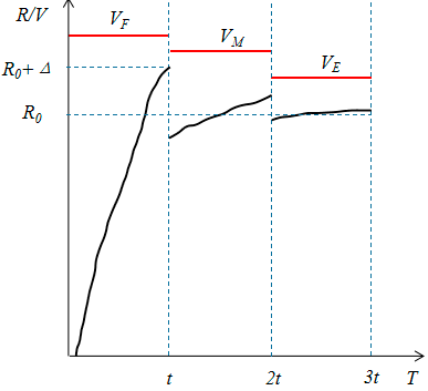
Figure 3. Design of the driving waveform for amplitude–frequency mixed modulation.